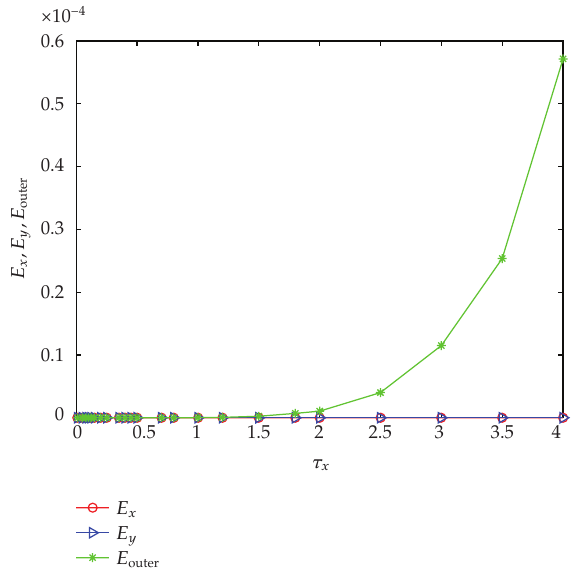
Figure 8: The plot show E x ,E y , and E outer versus τ x with τ y (cid:7) 0 . 5, r y (cid:7) 0 . 3, r x (cid:7) 1 . 2, ρ 1 (cid:7) − 0 . 3, and ρ 2 (cid:7) 0 . 6. where (cid:2) − C (cid:3) (cid:7) −{ C im } , (cid:2) − D (cid:3) (cid:7) −{ D jk } are the Laplacian matrices: (cid:5) N and D jk (cid:7) 0 for all j ; obviously, the di ff usive couplings k (cid:7) 1 the synchronized manifold. The parameters are chosen as the same as those in Figure 8, and individual couplings C, D are taken as two random matrices. Numerical results show that the adding individual connections have little e ff ect on inner and outer